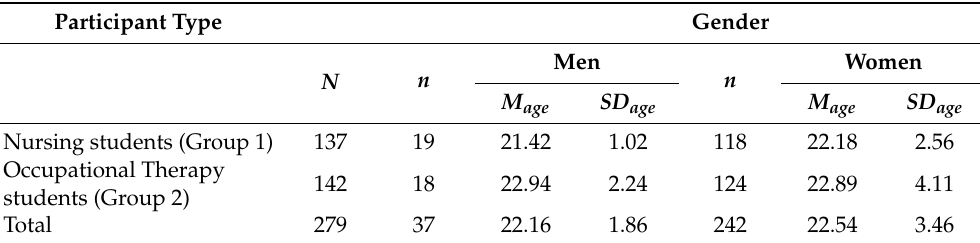
Table 1. Description of the sample regarding the variables gender and